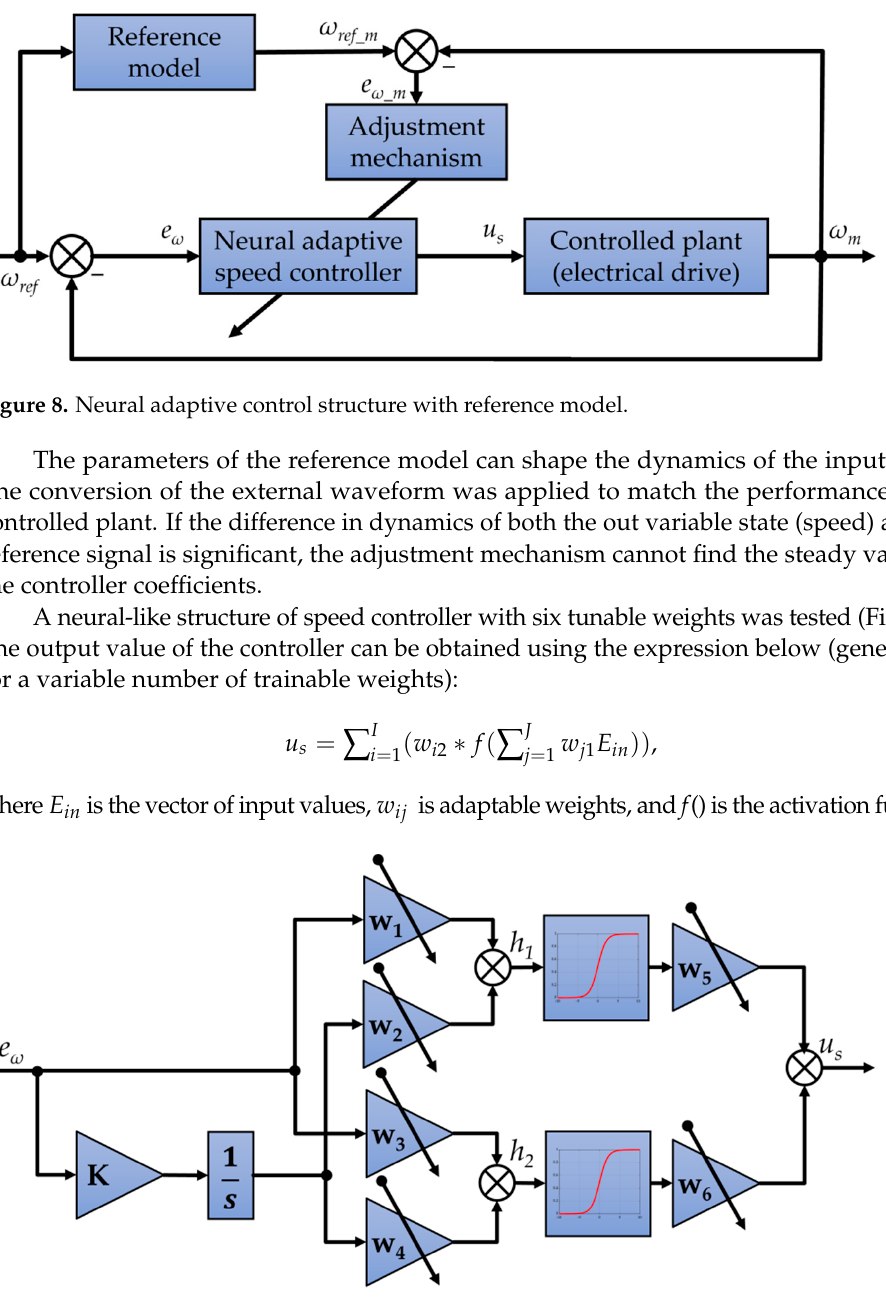
Figure 9. Structure of neural adaptive speed controller.